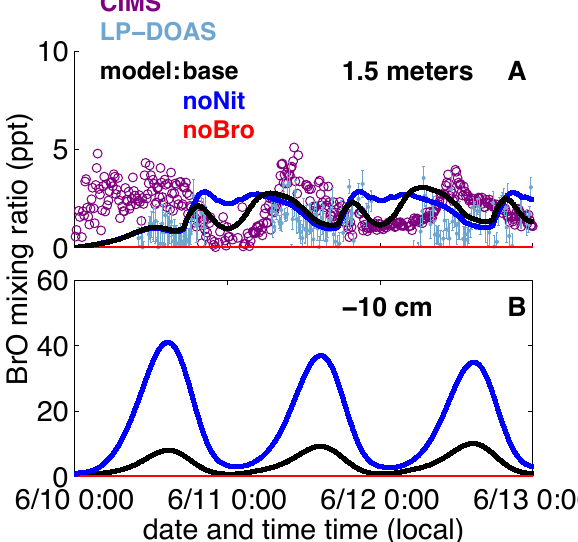
Fig. 2. Model predicted BrO for a three day model run for the base, noNit, and noBro cases compared to measurements of BrO using CIMS and LP-DOAS techniques during 10–13 June 2008. With- out bromide in the liquid layer, no BrO is predicted showing that snow sourced bromine is the only source of reactive halogens in the model. Without snow sourced NO x the amount of BrO predicted increases due to bromine loss processes that involve NO x in the gas phase.